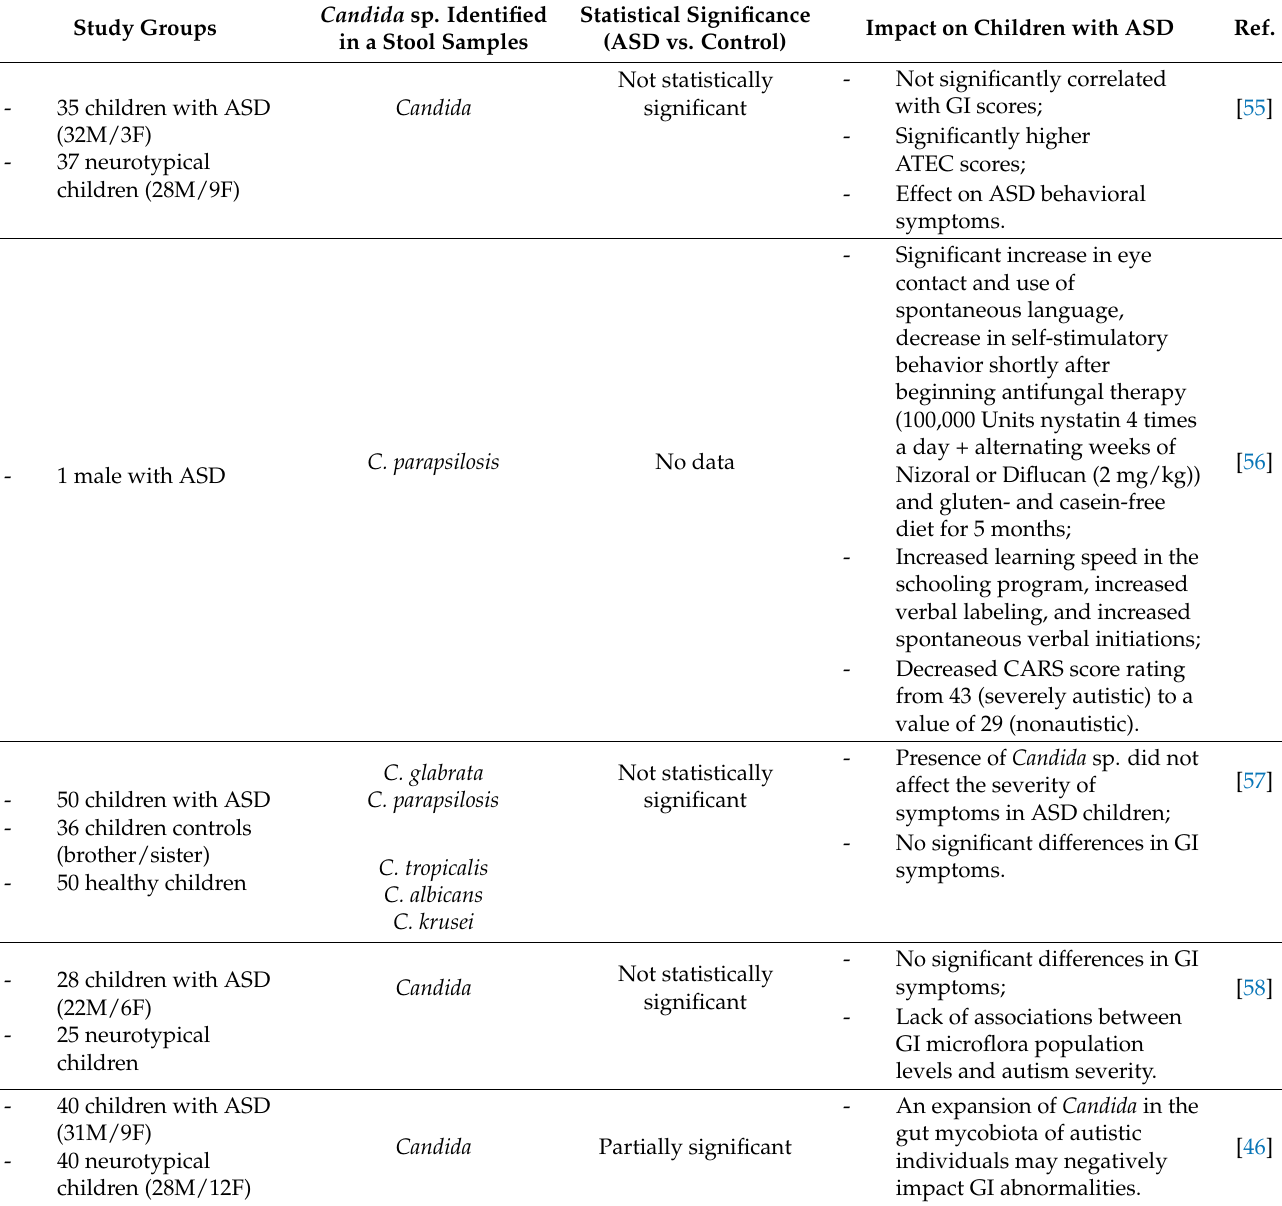
Table 1. Candida sp. in stool samples from children with